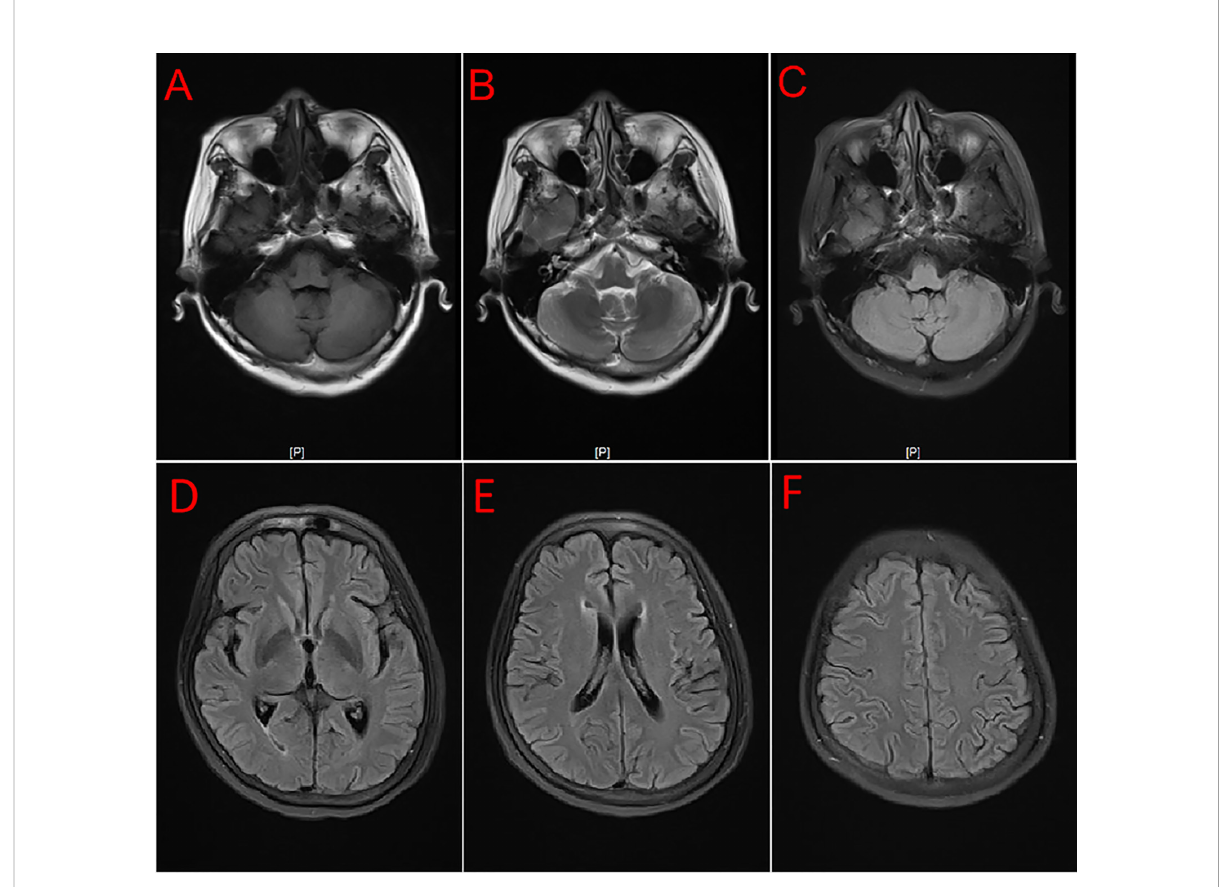
FIGURE 3 MRI showed no typical imaging features for APS and brain lesions. T1 (A) , T2 (B) , and Flair (C – F)